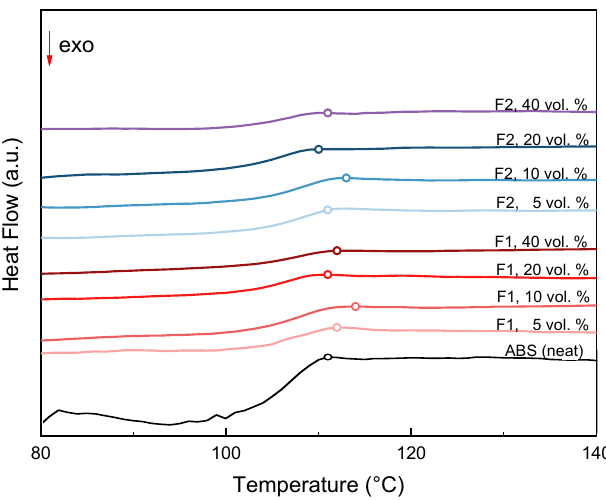
Figure 7. DSC diagrams for different ABS/filler composites and neat ABS. Open circles denote glass transition temperature.